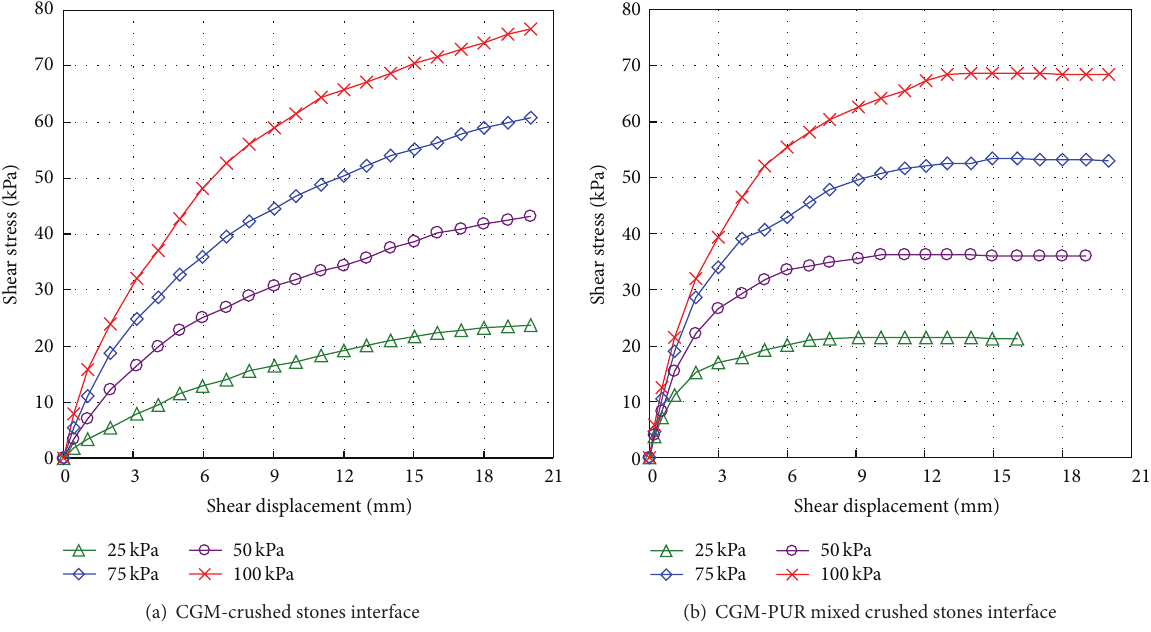
Figure 5: Shear stress versus shear displacement of CGM-cushion interfaces.